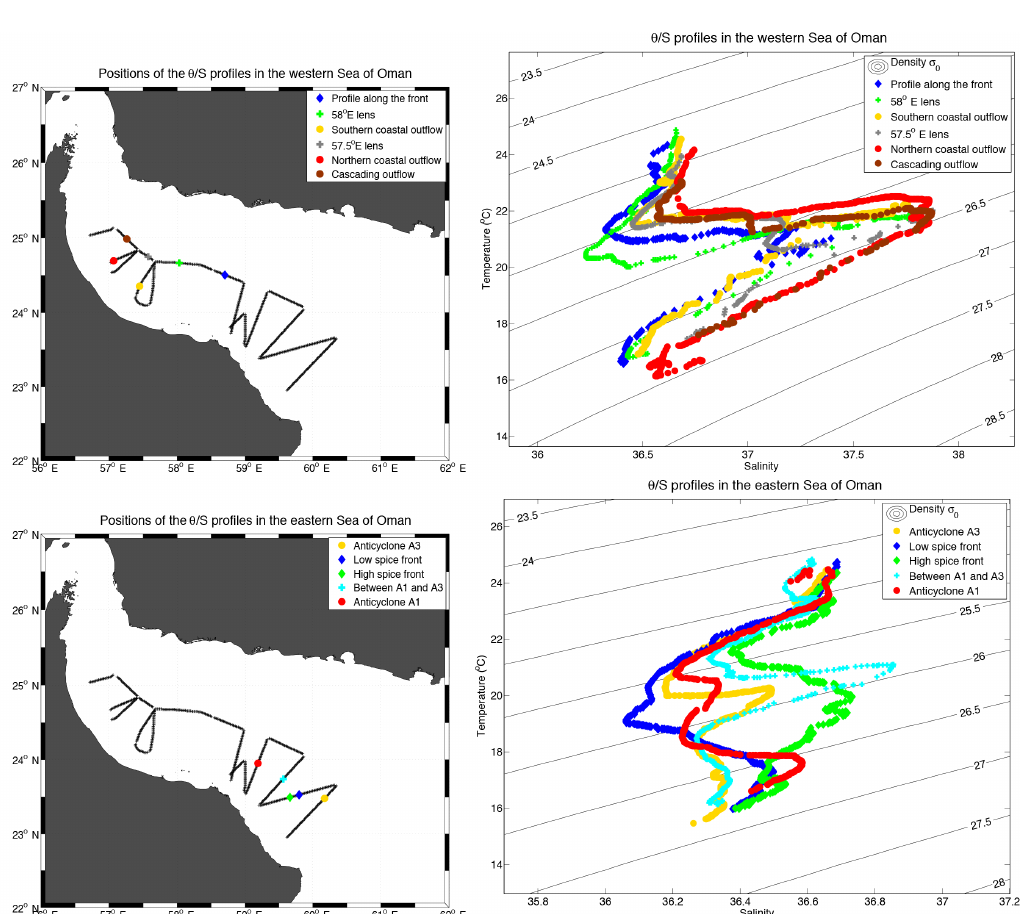
Figure 7. Potential temperature over salinity profiles (right) and their locations of interest (left); in the western Sea of Oman (top) and eastern Sea of Oman (bottom). Top panel: blue diamond: profile out of the salty outflow; green cross: 58 ◦ E lens; yellow circle: southern profile in the PGW outflow along the coastal slope; grey cross: 57.5 ◦ E lens; red circle: northern profile in the PGW outflow along the coastal slope; brown circle: cascading PGW outflow. Bottom panel: yellow circle: profile inside anticyclone A3; blue diamond: low spice profile, observed in the periphery of A3; green diamond: high spice profile, observed in the periphery of A3; cyan cross: at the periphery of anticyclones A1 and A3; red circle: profile inside anticyclone